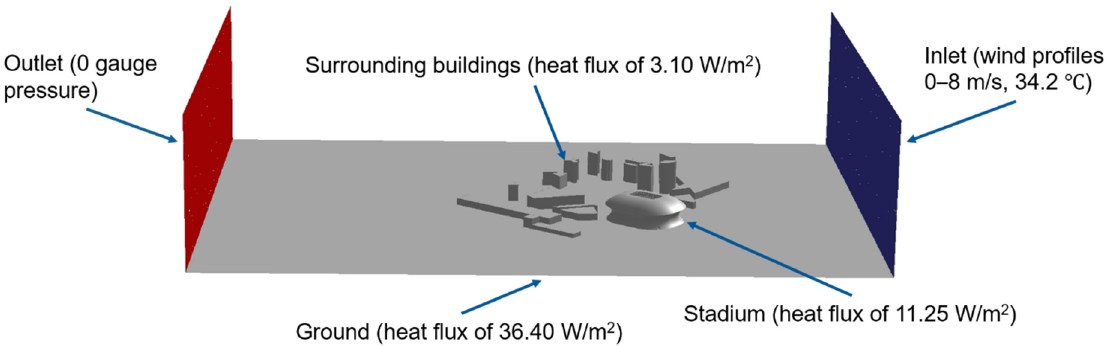
Figure 5. Boundary conditions as defined for the CFD model.